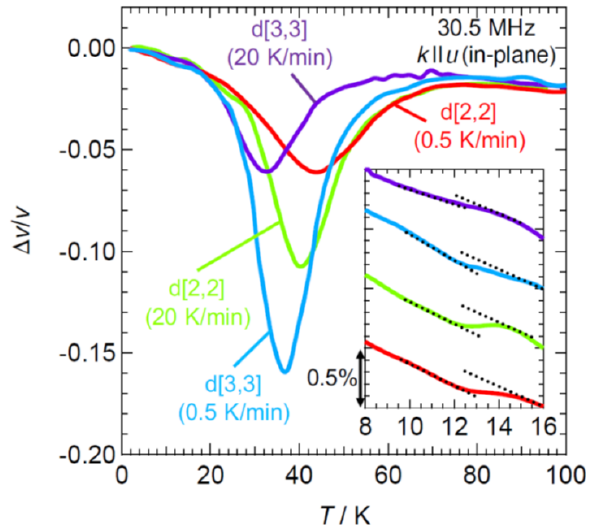
Figure 3. Temperature dependences of the relative change of the sound velocity (Δ v / v ) for the partially deuterated d[3,3] compound and d[2,2] compound obtained with two cooling rates of 0.5 K min −1 and 20 K min −1 . The inset shows the sound velocity anomaly around the superconducting transition temperature.